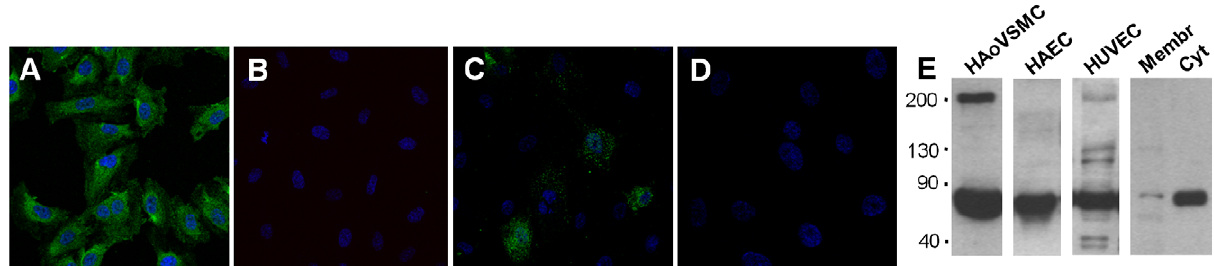
Figure 1. CaSR protein expression in HUVECs by Immunofluorescence Confocal Microscopy and Western Blot. Immunofluorescent localization of CaSR in HUVECs with specific antibody and negative control after fixation and permeabilization protocol (A and B), or after fixation but not membrane permeabilization (C and D). Representative Western Blot of CaSR protein levels in HAoVSMC, HAEC and HUVEC total lysate, and in HUVEC membrane and cytoplasm extracts (E).